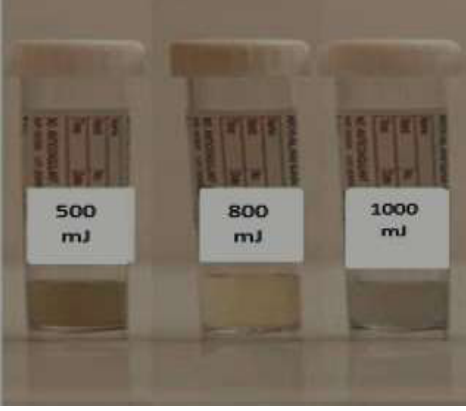
Figure 3: Al 2 O 3 NPS colloidal prepared by laser ablation at different energy (500, 800, and 1000) mJ. The AFM images for the nanostructures deposited utilizing 500,800.1000mJ energy are shown in Figure 4. The topography of the surface of Al 2 O 3 NPS particles was studied and measurements of surface roughness, particle size nanoparticles rate, and particle size distribution were taken. The SEM image of the sample as shown in Figure 5 (A, B, C) reveals that the particles are spherical and have granular nature. In the higher resolution SEM image, the agglomeration of particles is observed. Aging may have caused the agglomeration. The size distribution of the Al 2 O 3 NPS sample was evaluated using ImageJ software. the size average value of particles is arranged from 40 to 60 nm.